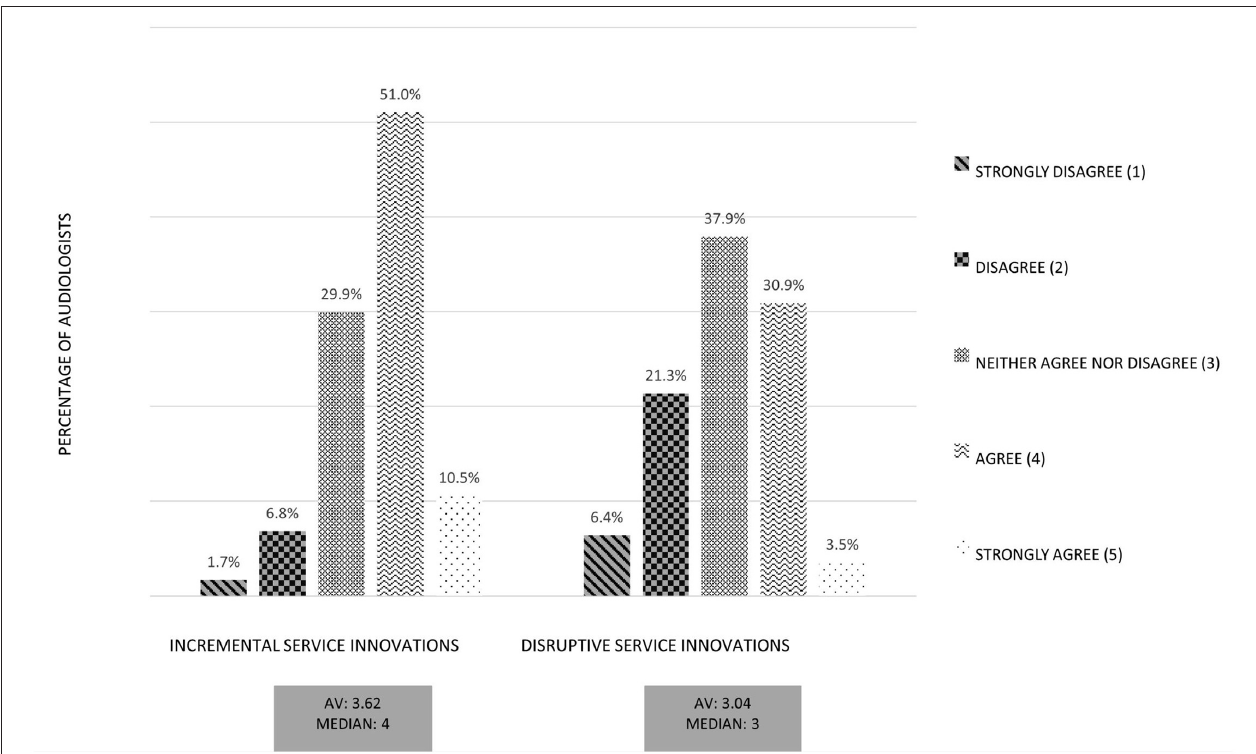
FIGURE 5 | Comparison of incremental service innovations and disruptive service innovations: Aggregated factor Technology Acceptance. Exemplary Item: “I would like to work with the digital service”